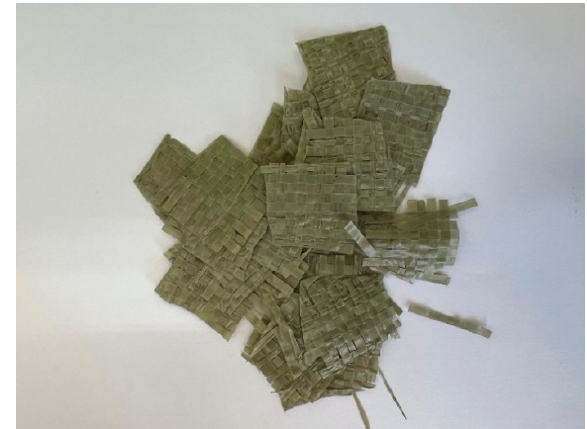
Figure 3. Waste PP modifier.